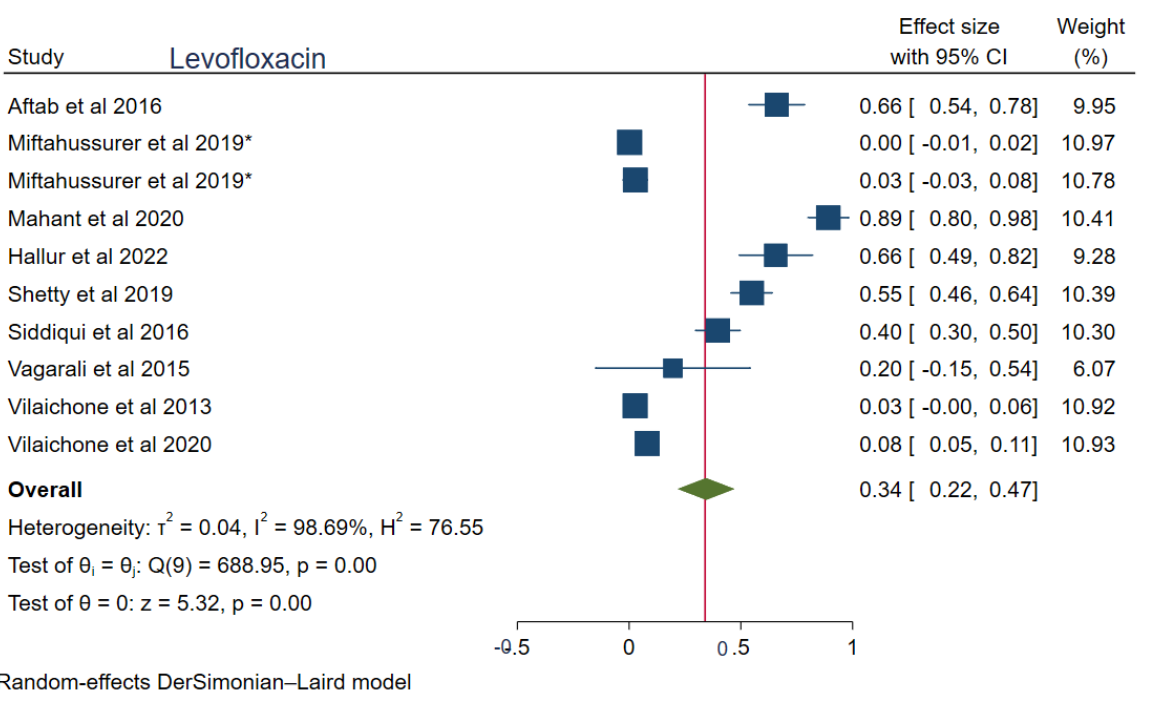
Figure 6. Forest Plot Showing Levofloxacin Resistance. (*: the same study with data from two countries, Reference studies: [14, 15, 20, 22, 26, 31, 34, 37, 38]